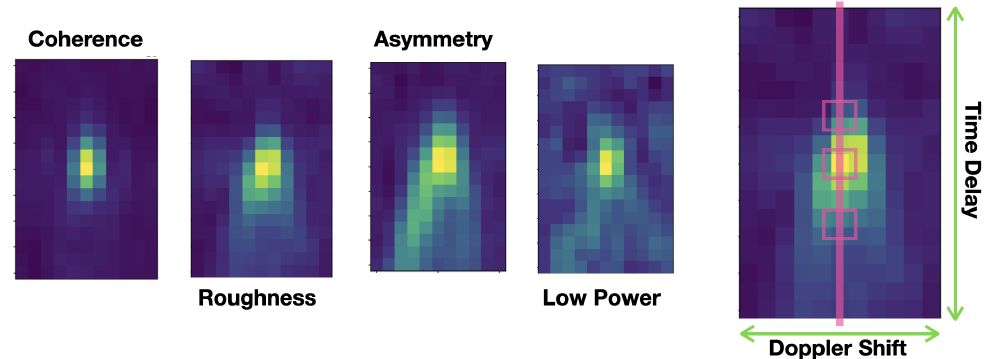
Figure 2. Examples of DDM features with changing surface conditions (1–4, from left to right). An example of data reduction through selection of a single profile or individual points (rightmost, extracted values represented by line and squares).